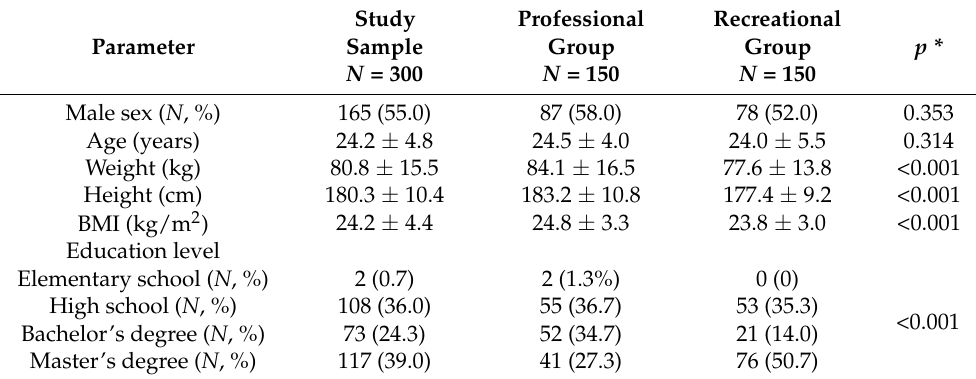
Table 1. Baseline characteristics of the study